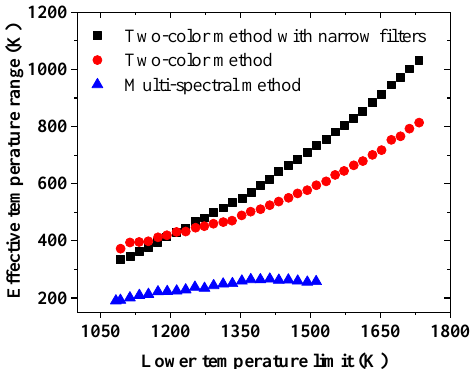
Figure 8. Comparison of effective temperature ranges using color CCD cameras with different strategies. The square symbols and circle symbols represent results using two-color thermometry with and without multi-peak interference in front of CCD cameras, respectively. The triangle symbols represent results from multi-spectral thermometry